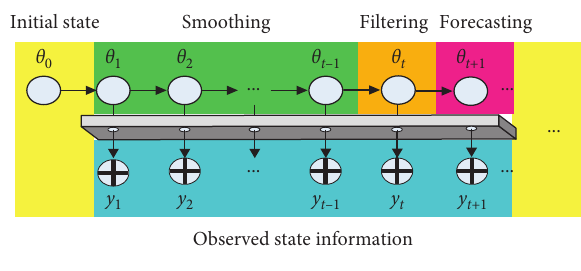
Figure 2: The process of state estimation. The initial system state θ 0 and the observed states y i 􏼈 􏼉 from time point i � 1 to point i � t are at time t + 1 is required to be pre- known. The system state θ t + 1 dicted by smoothing and filtering